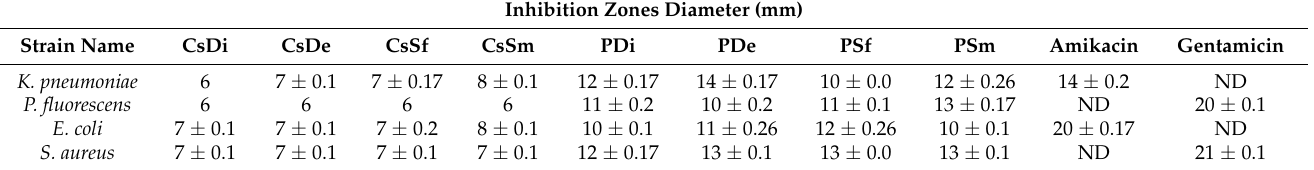
Table 6. Inhibition zones of Cannabis sativa leaf extracts without and with AgNPs. CsDi—Diana leaves extracts; PDi—Diana leaves extracts + AgNPs; CsDe—Denise leaves extracts; PDe—Denise leaves extracts + AgNPs; CsSm—Silvana male leaves extract; PSm—Silvana male leaves extract + AgNPs; CsSf—Silvana female leaves extract; PSf—Silvana female leaves extract +